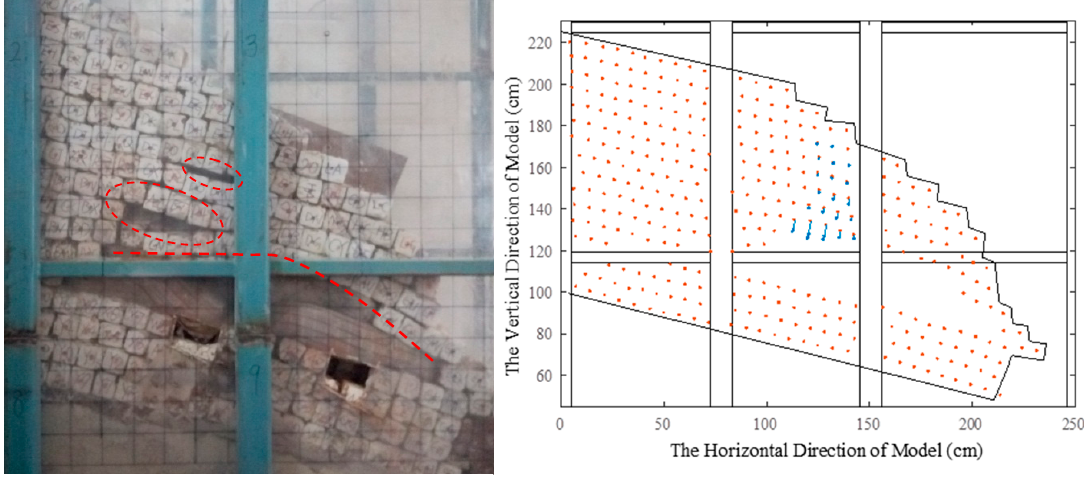
Figure 9. Slope deformation and displacement vector after mining ore body #1.